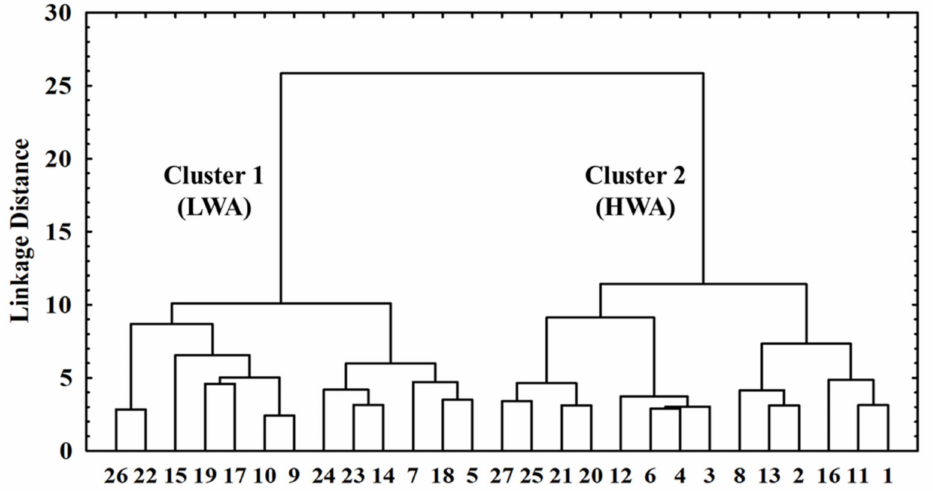
Figure 1. Dendrogram of Brazilian dry-cured loin samples. Cluster 1 (LWA, low water activity) and cluster 2 (HWA, high water